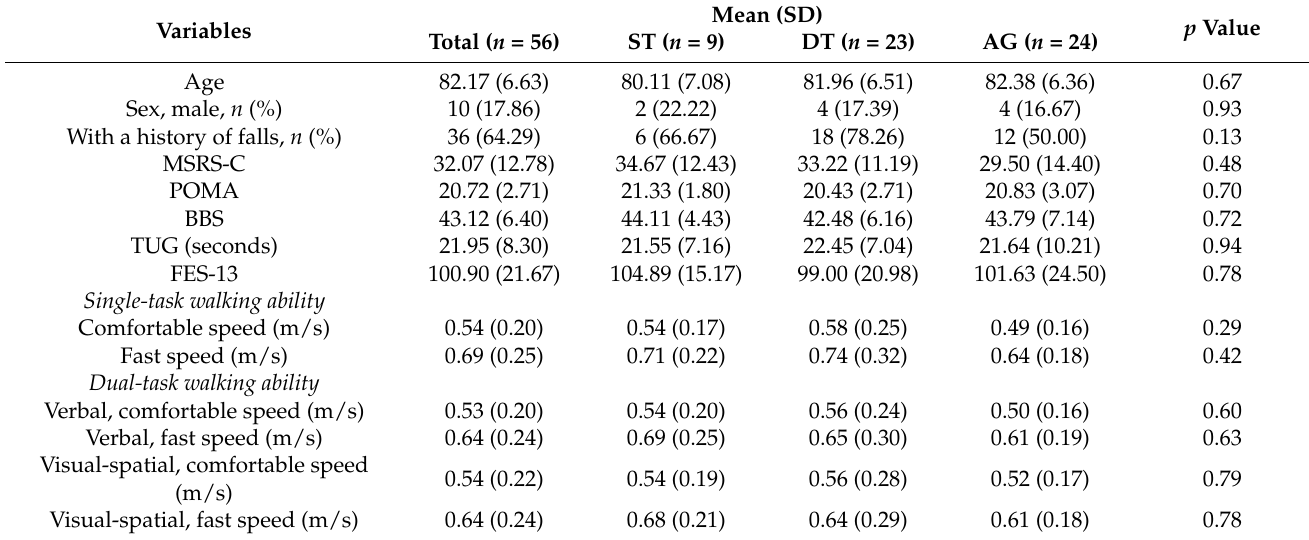
Table 1. Participants’ characteristics at baseline (T0).